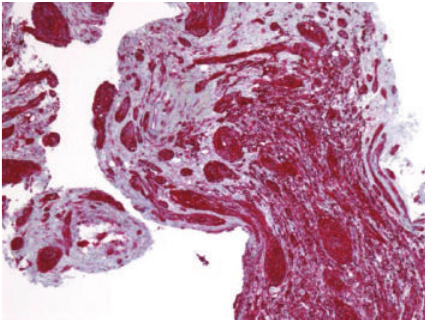
Figure 7: Perivascular wall tumor; right piriform lobe. The prolifer- ative tumor cells displayed a positive reaction for vimentin.